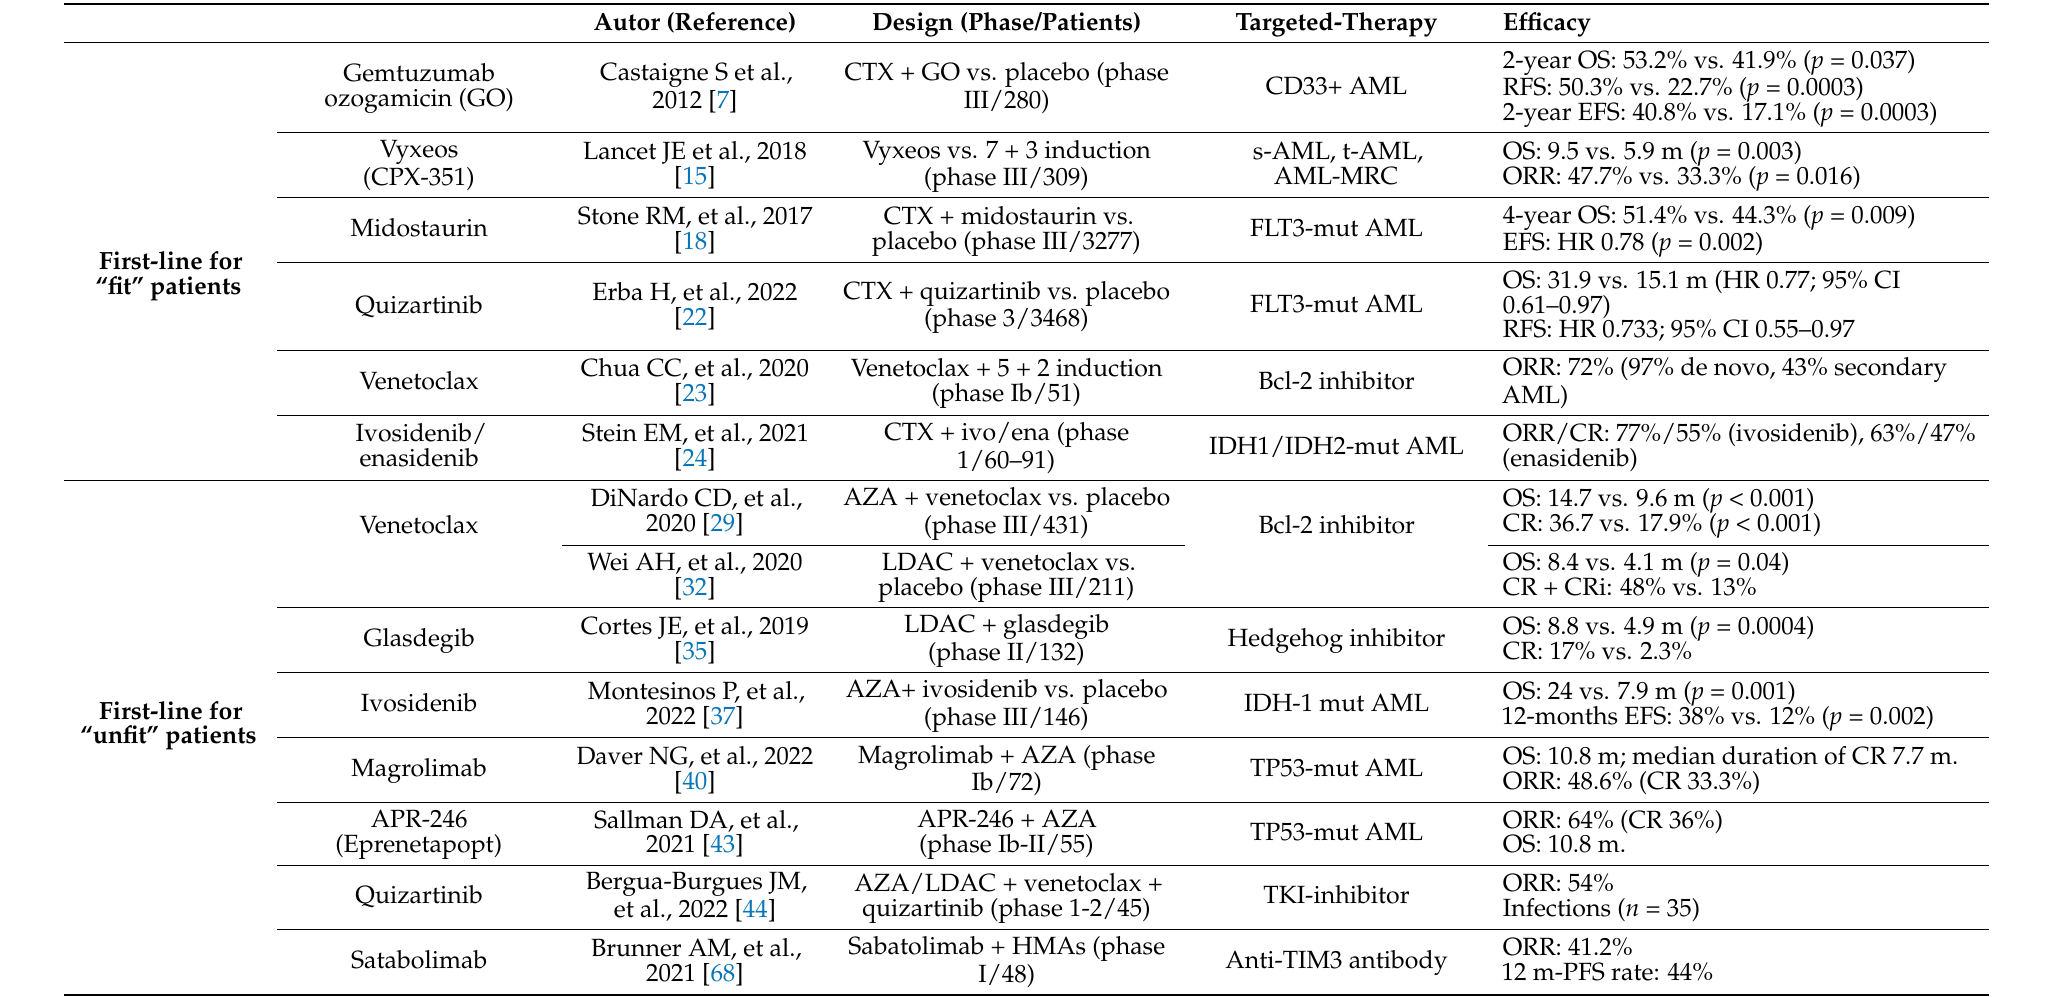
Table 1. Summary of main trials with new targets and therapies for acute myeloid